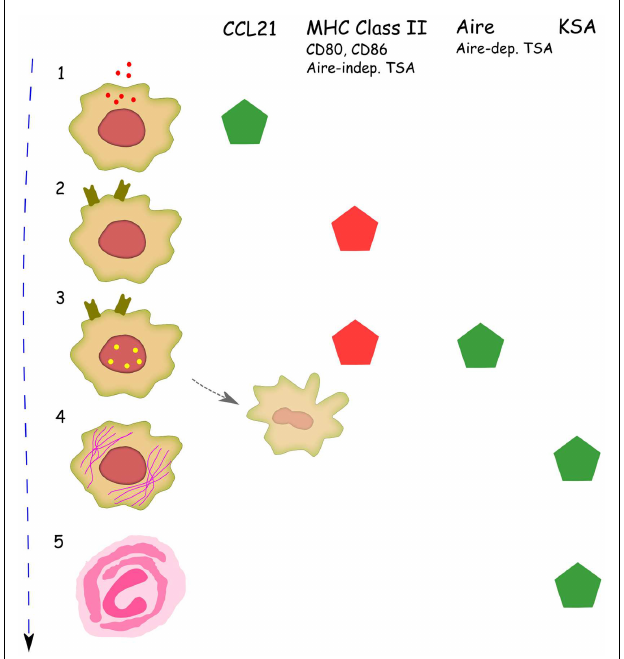
FIGURE 2 | Proposed program of mTEC differentiation and the effect of Aire on mTEC development at different stages of differentiation . Consecutive developmental stages are indicated based on key molecules predominantly expressed at this stage: (1) MHC class II − , CCL21 + *; (2) MHC class II + , Aire − ; (3) MHC class II + , Aire + ; (4) MHC class II-low, Aire − , keratin high; (5) Hassall’s corpuscles. Possible pathway from MHC II + , Aire + cells to apoptosis is shown in pale.The pentagonal signs indicate presence of the specific marker at this stage of differentiation, whereas the color of a sign indicates the change of this marker in the Aire-deficient mice: green corresponds to a decrease and red to an increase in Aire KO mice.TSA stands for tissue-specific antigens and excludes keratinocyte-specificTSAs; KSA stands for keratinocyte-specific antigens. *In parallel to the developmental sequence presented here, the MHC class II − , CCL21 + mTEC stage has been suggested to follow the MHC class II + , Aire + stage of development